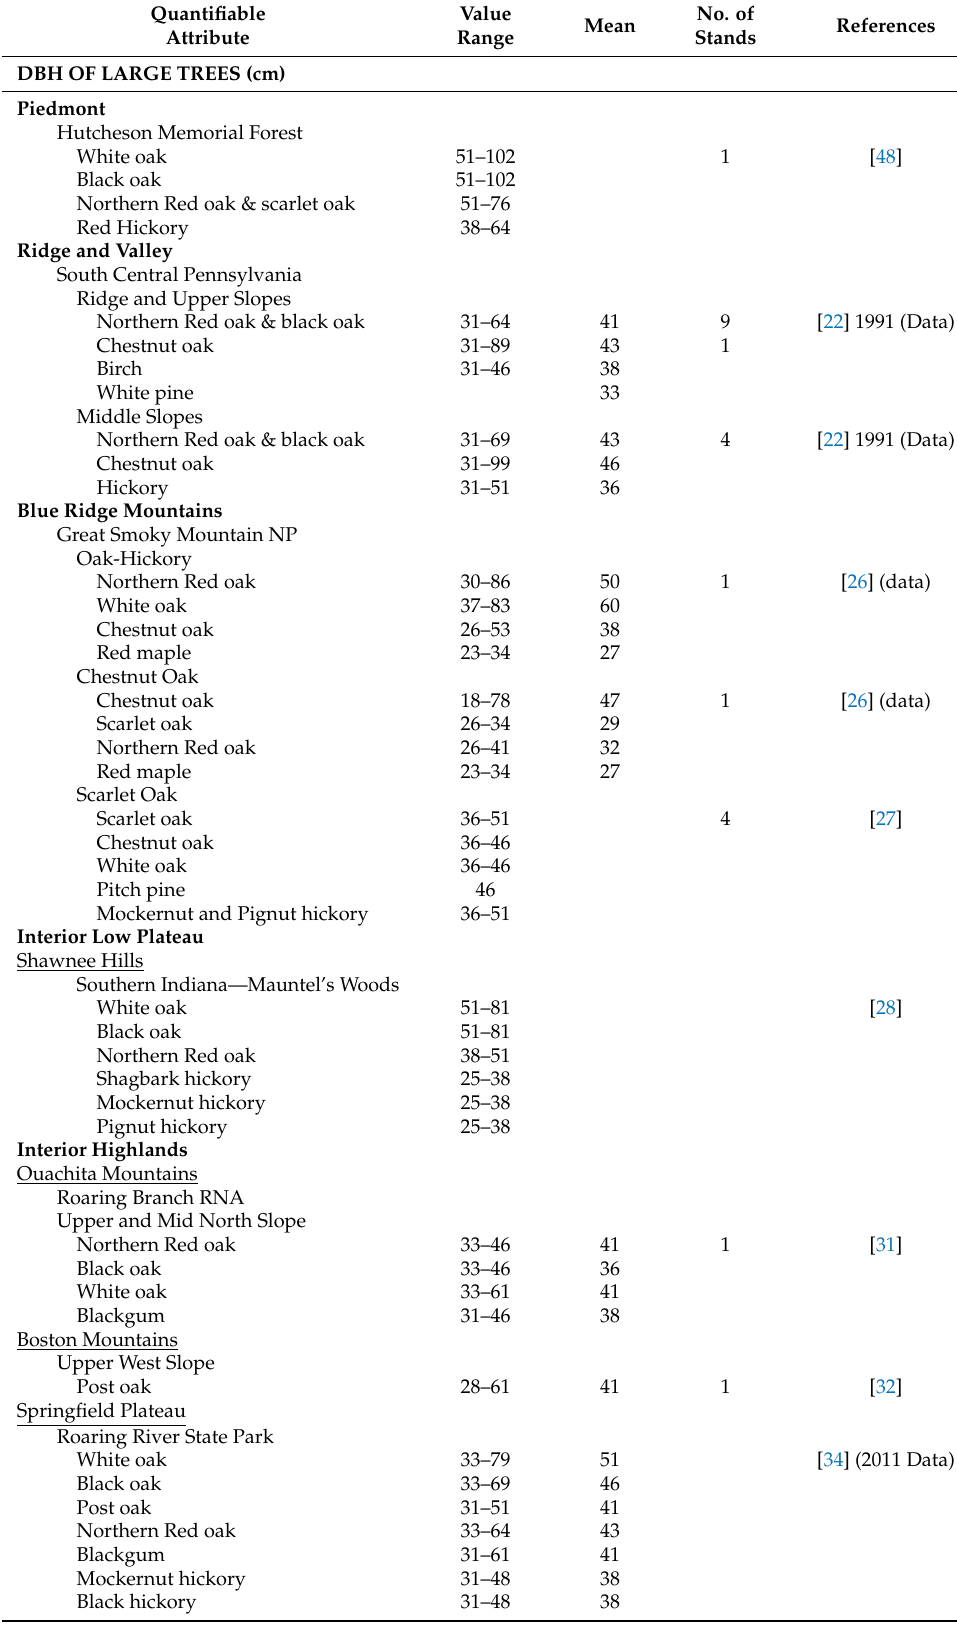
Table 4. DBH (cm) of large trees (dominant and codominant crown class) of representative dry-mesic old-growth oak